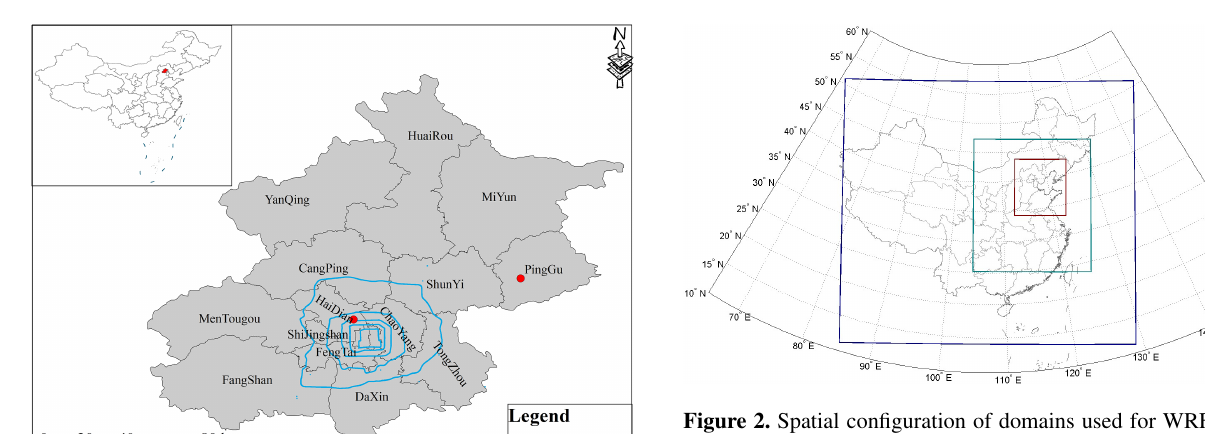
Figure 2. Spatial configuration of domains used for WRF simula-